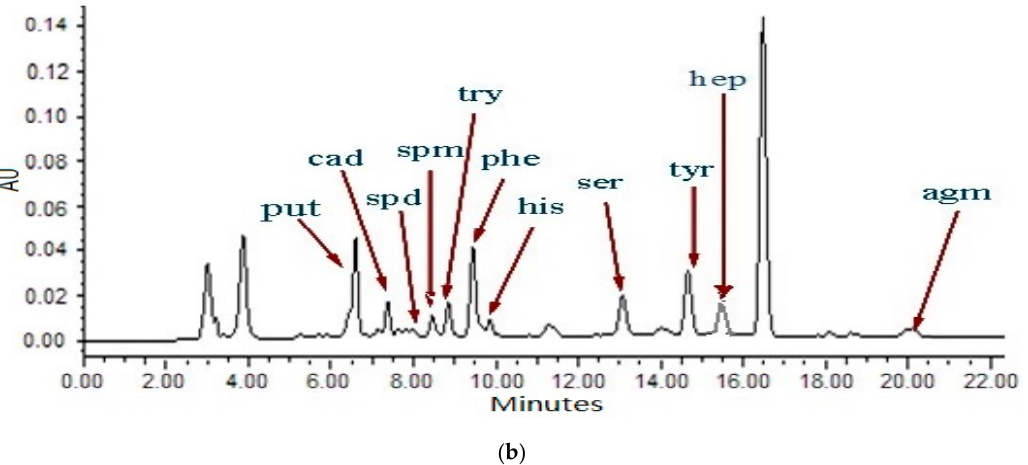
Figure 1. Chromatogram of derivatives of BA standards (5 µ g / mL) ( a ) and BAs in soy sauce ( b ).